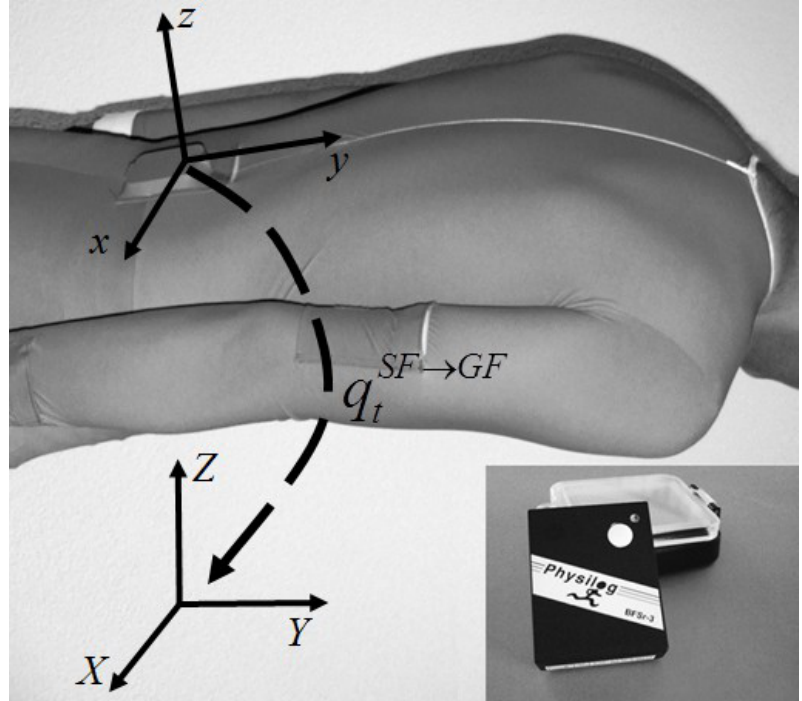
Figure 1. The inertial sensor with water proofing box and its placement. The global frame (GF: X, Y, Z) and the sensor frame (SF: x, y, z) and relative quaternion SF GF represents sensor frame data in the global frame is also